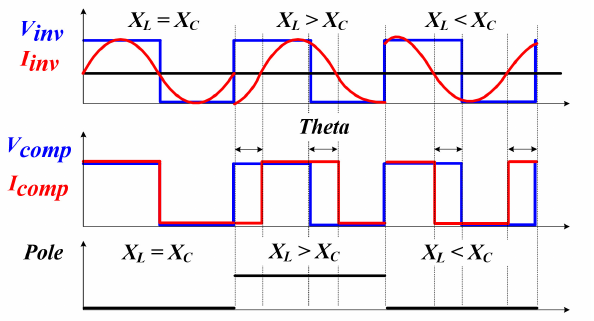
Figure 9. Phase graph of conventional resonance tracking method according to the time change.